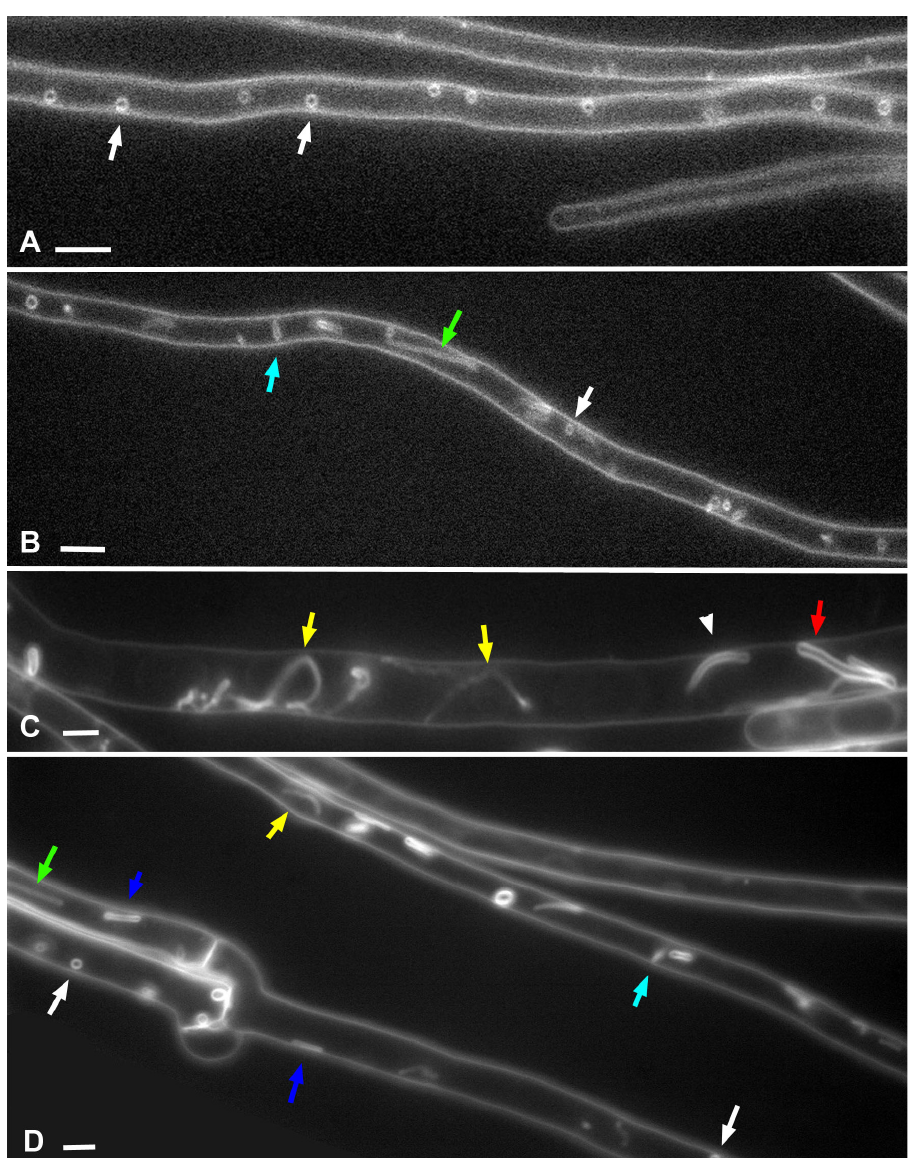
Figure 5. Small vesicles and thin tubes in the hyphae of O. olearius . Designations: white arrows— small vesicles, light blue arrows—standing thin tubes, blue arrows—longitudinal tubes pressed to the PM, green arrows—longitudinal straight tubes, yellow arrows—longitudinal curving tubes, red arrow—thick tube (> 1 µm in diameter), arrowhead—tube of intermediate thickness (700–800 nm). ( A , B )—the single focal planes. ( C , D )—Z-stacks summation. Scale bars are 5 µm. In addition to thin tubes located entirely or partially across the hypha and visualized most often as small vesicles, fungal cells contain other types of thin tubes that are visible in single focal planes as tubes with a diameter less than 500 nm, not vesicles. The occur- rence of such tubes is, on average, 6.5 times lower than that of small vesicles (in the basic variant of treatment). This includes straight thin tubes located perpendicular to the PM— R = 0.61, p <